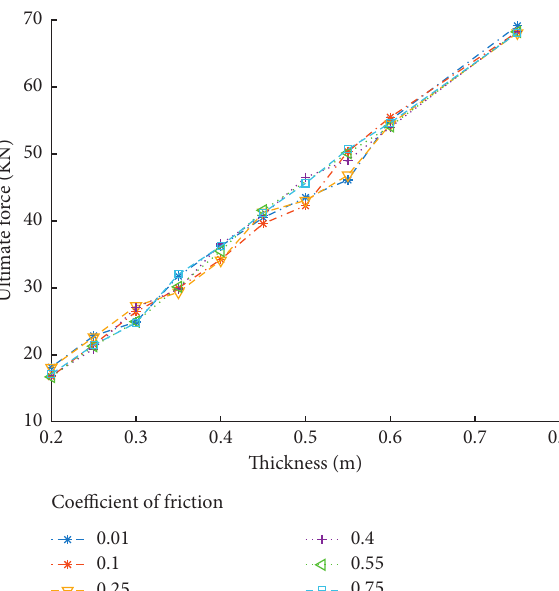
Figure 9: Yield displacement vs length for varying compressive strengths.